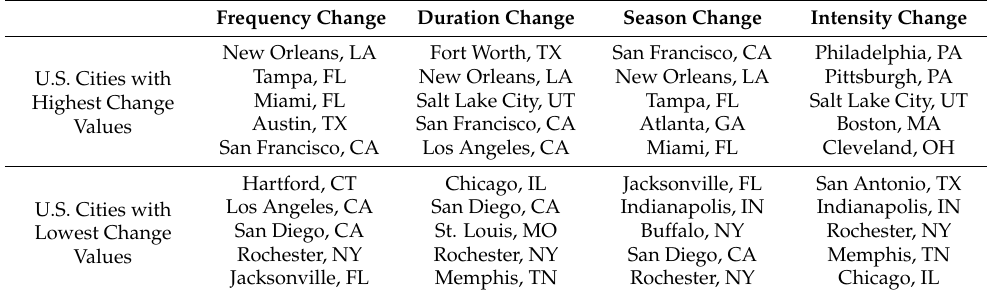
Table 9. U.S. cities with the highest and lowest frequency, duration, season, and intensity change